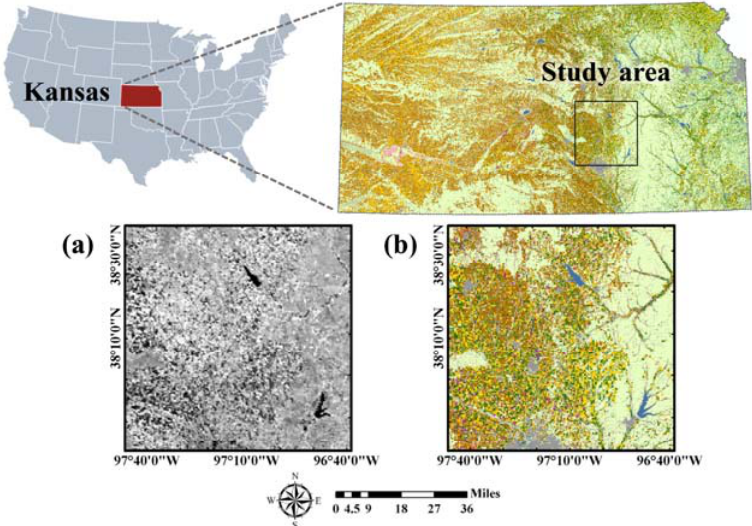
Figure 1. Location of the study area and data sets: ( a ) Moderate Resolution Imaging Spectroradiometer (MODIS) Normalized Difference Vegetation Index (NDVI) on 9 May 2015, at a 250 m spatial resolution and ( b ) cropland data layer (CDL) 2015 at a 30 m spatial resolution.